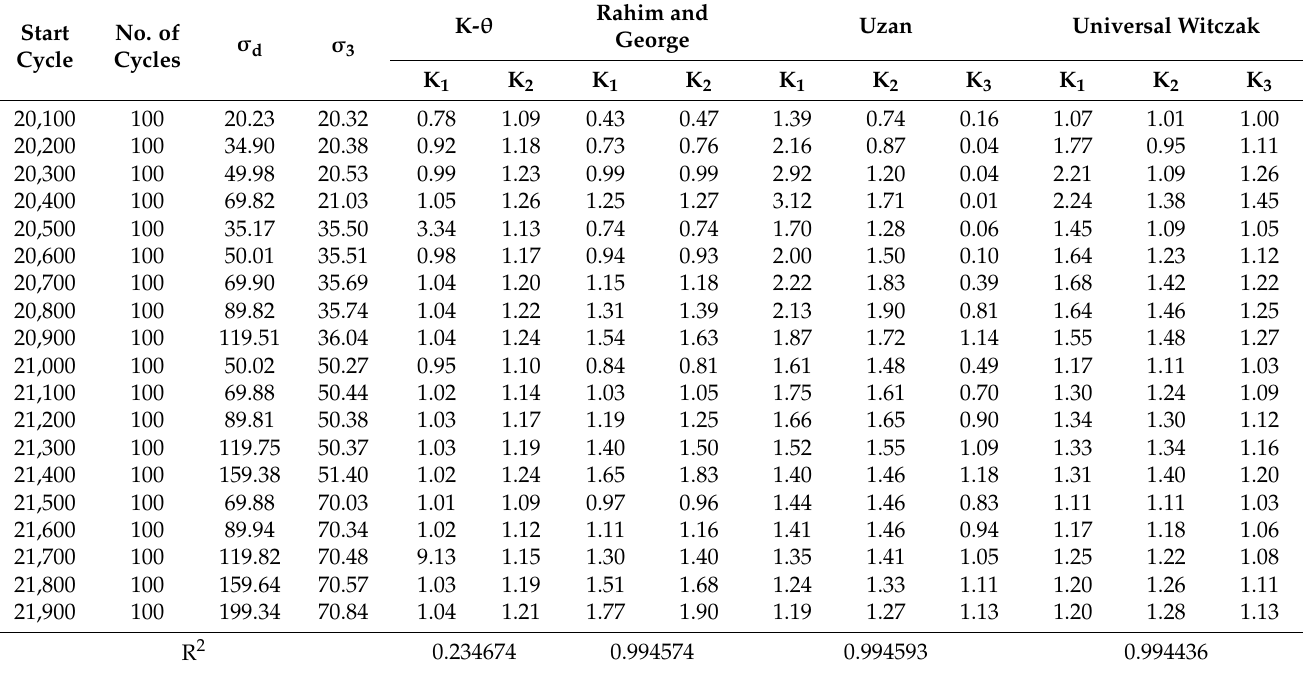
Table 6. Determination of models’ average regression coefficients for specimen SG2.